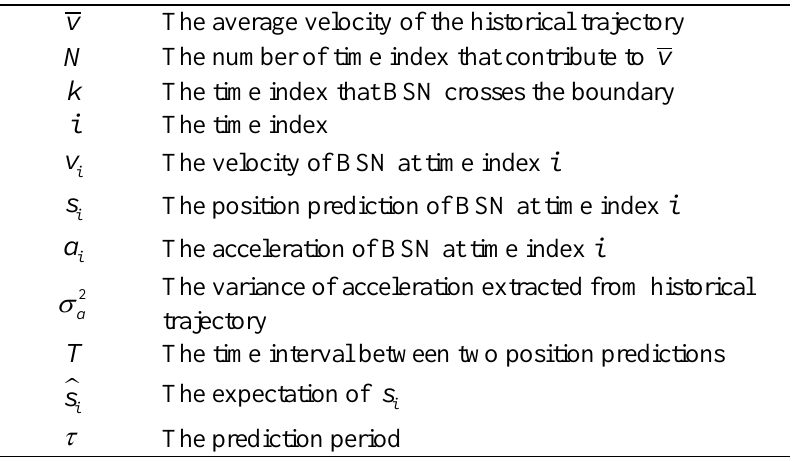
Table 1. The notations of the terms.